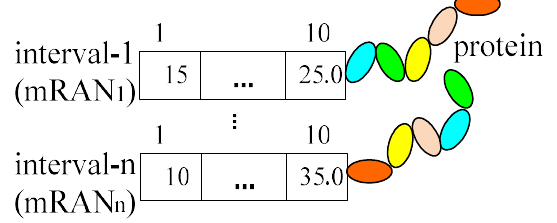
Figure 8. Picking the best proteome.